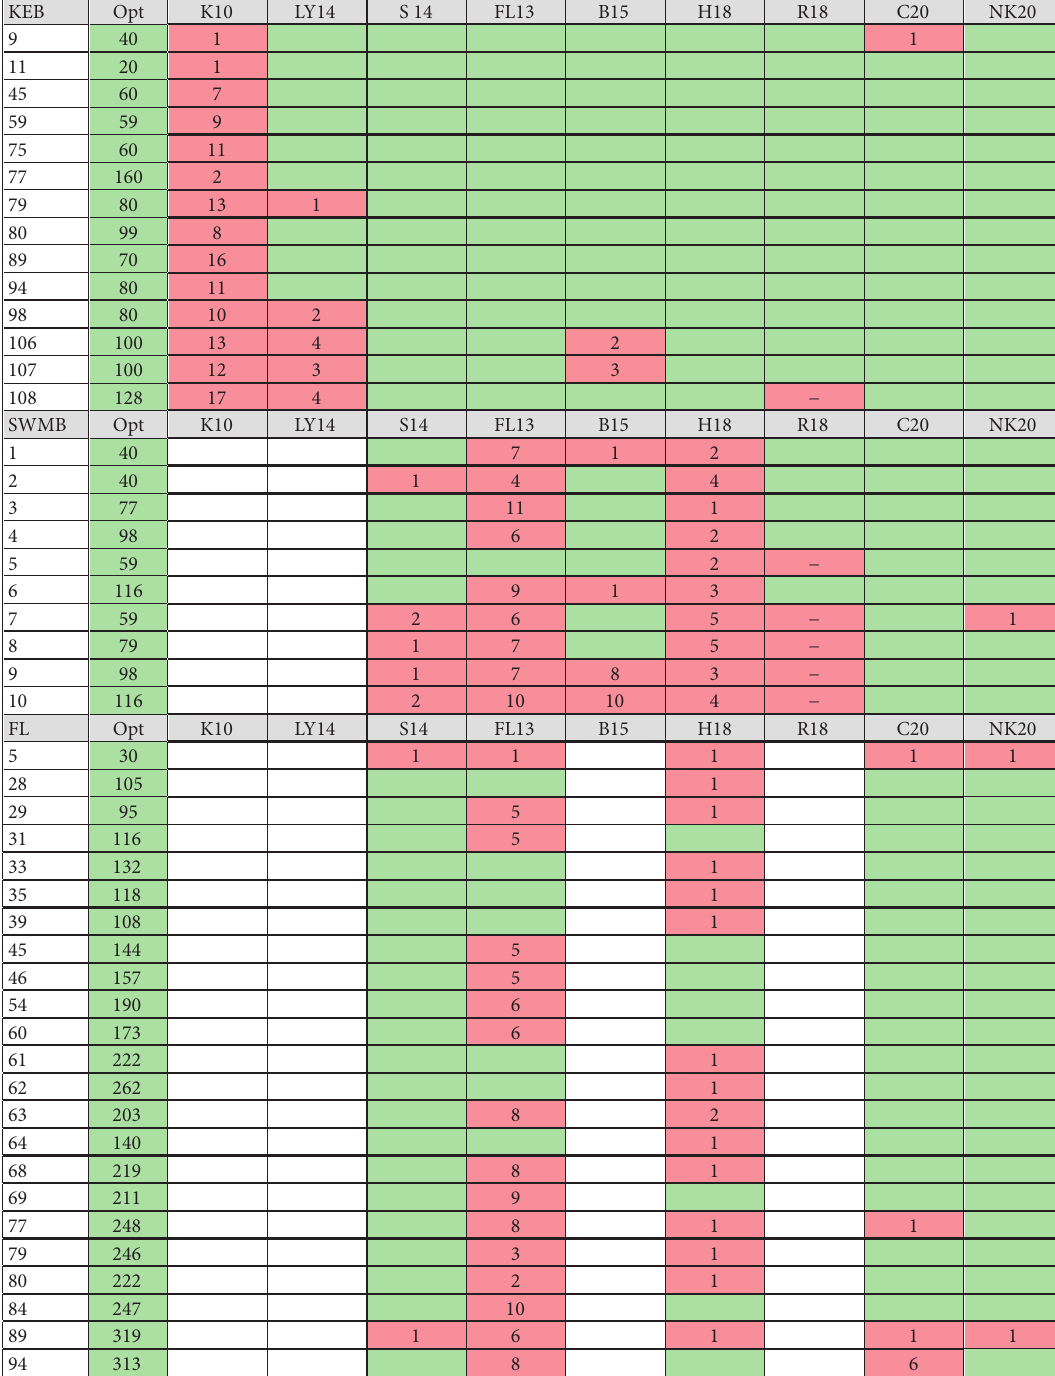
Table 5: The detailed results of nine solution methods for KEB, SWMB, and FL